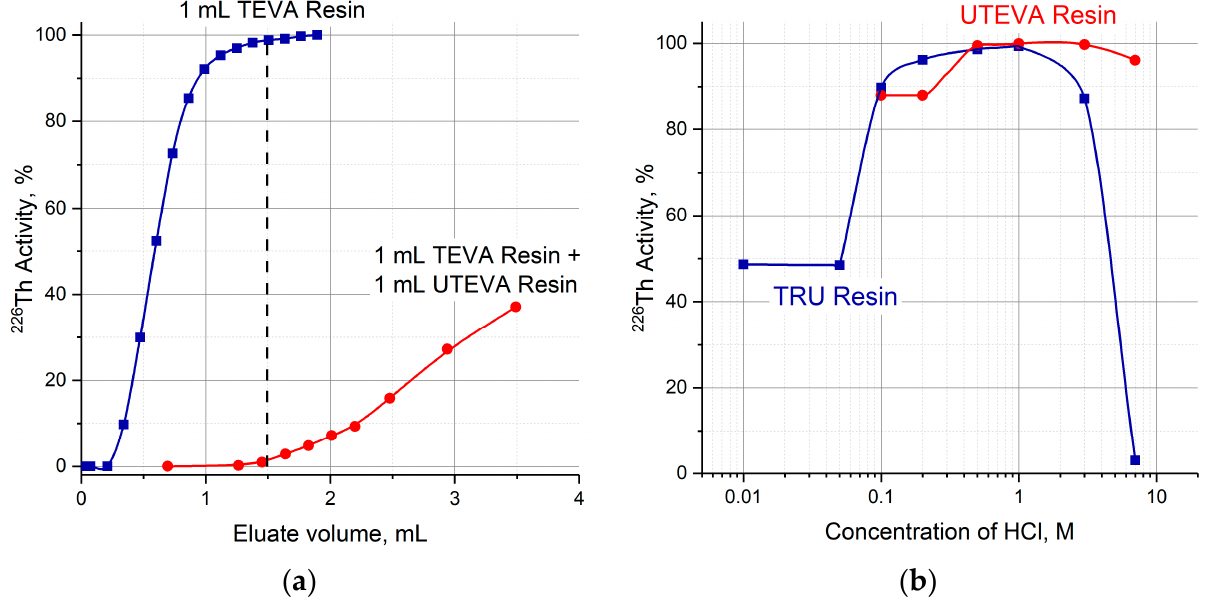
Figure 5. ( a ) Optimization of the UTEVA resin volume in the second column; ( b ) e ffi ciency of 226 Th desorption from TRU and UTEVA columns as a function of HCl concentration.